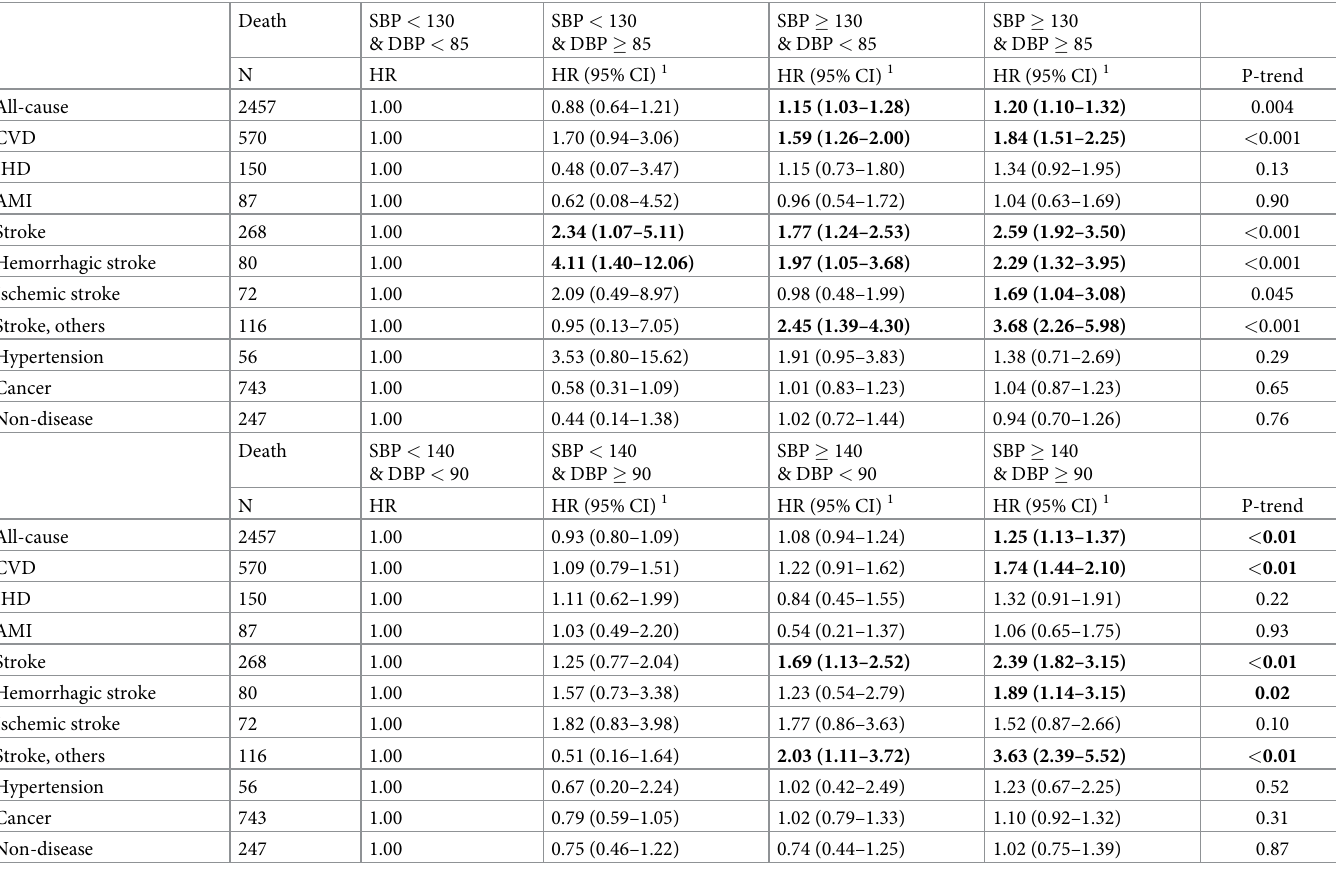
Table 1. Combined association of systolic blood pressure (SBP) and diastolic blood pressure (DBP) on the risk of mortality in the Korean Multi-center Cancer Cohort study over 15 follow-up